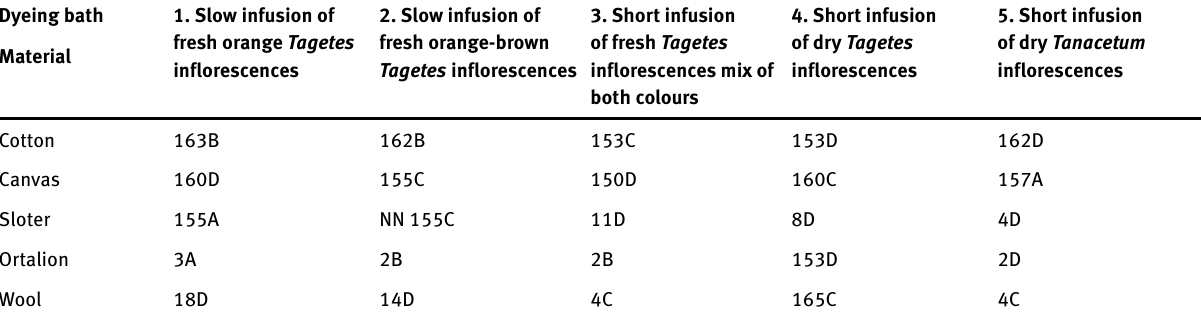
Table 3 : RHS colours of samples measured 30 days after dyeing Dyeing bath 1. Slow infusion of